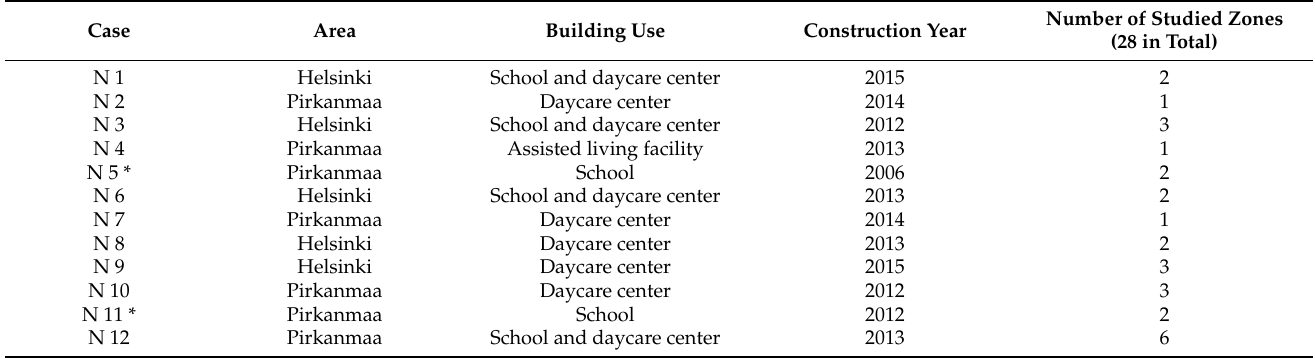
Table A1. The new case study buildings. The city of Helsinki is located in Southern Finland and the Pirkanmaa region in the southwest part of Finland. (*): Building has a new and retrofitted part.